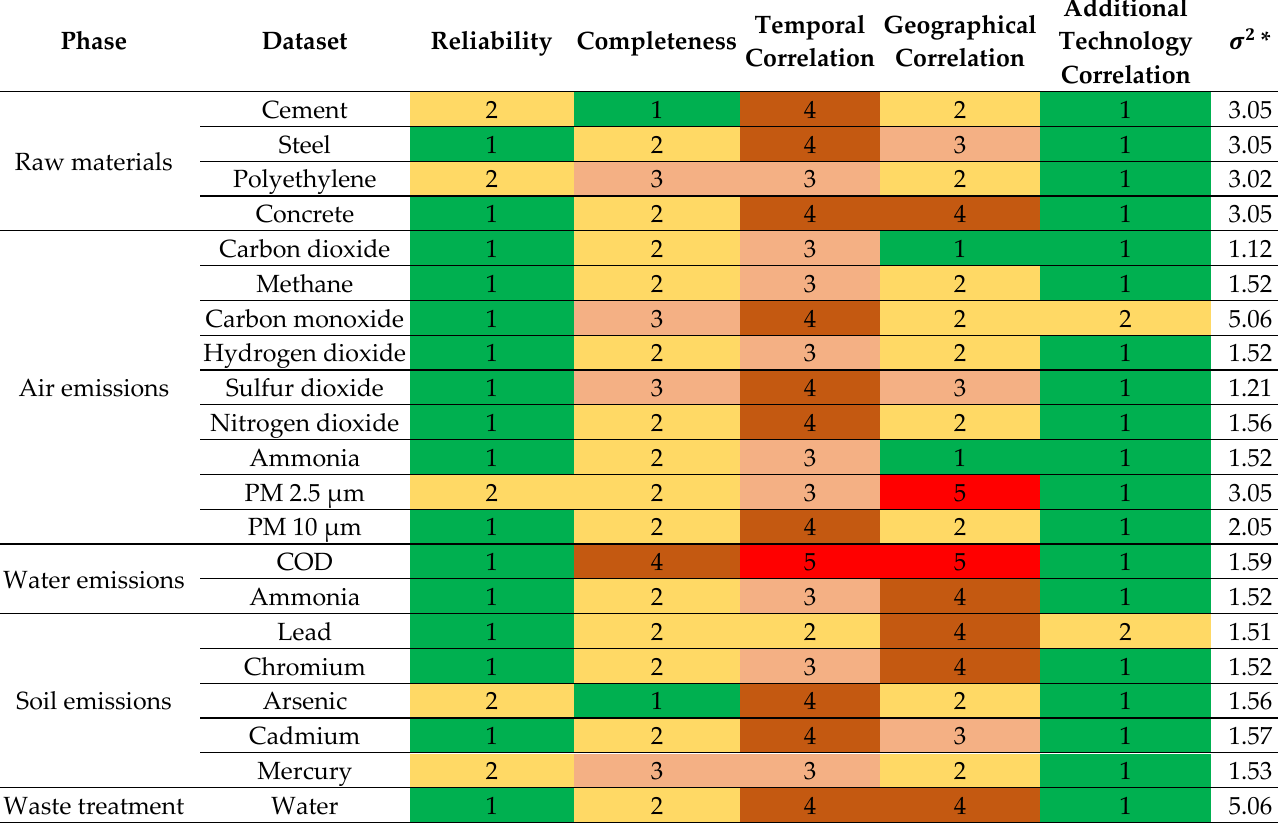
Table 9. Data quality assessment matrix DQI.